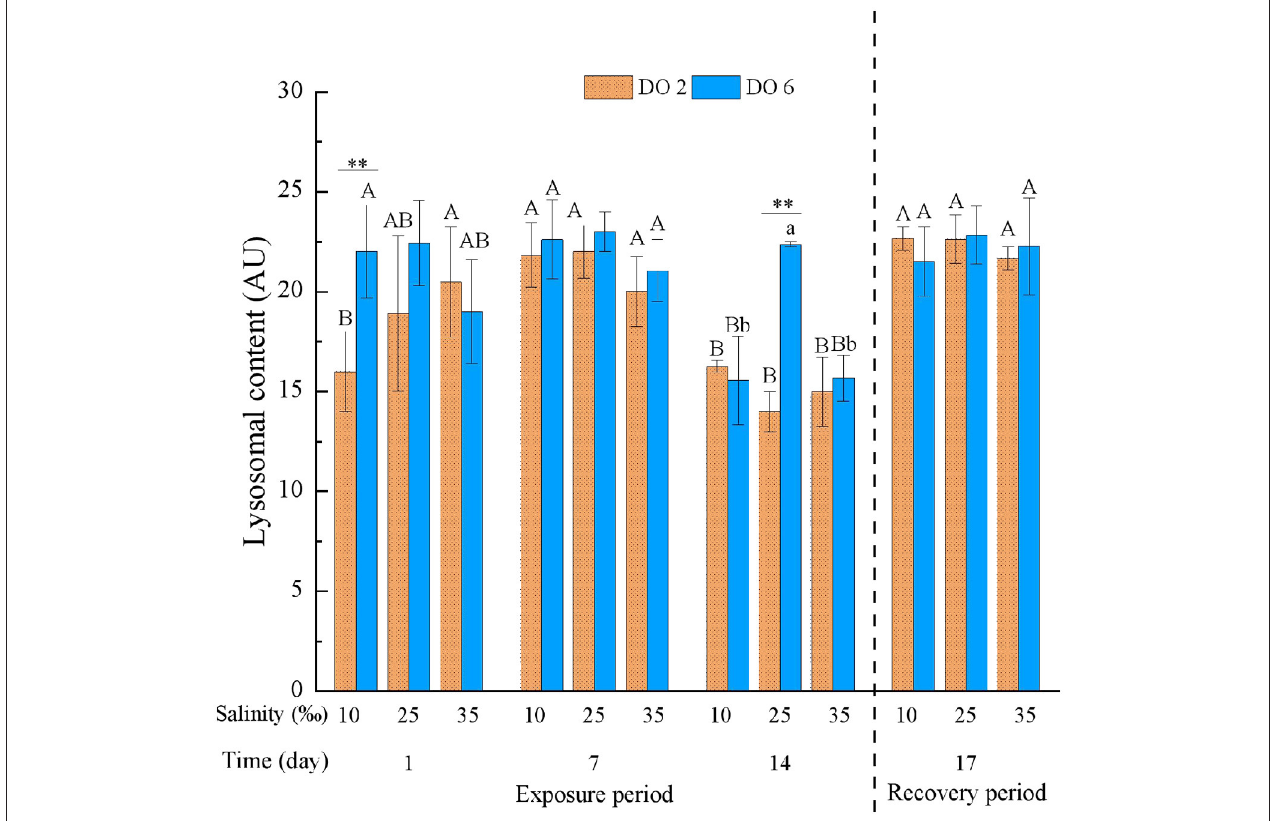
FIGURE 7 | Lysosomal content (LYSO) of C. hongkongensis exposed to six combinations of salinity (10, 25, and 35 ‰ ) and DO (2 and 6 mg/L) at 1, 7, and 14 days during the exposure period and 3 days for the recovery period. Different capital letters indicate significant differences among time points within each salinity level in hypoxia level (2 mg/L) or control group (6 mg/L) ( p < 0.05). Different small letters indicate significant differences between salinity within each time point in salinity level in hypoxia level (2 mg/L) or control group (6 mg/L) ( p <